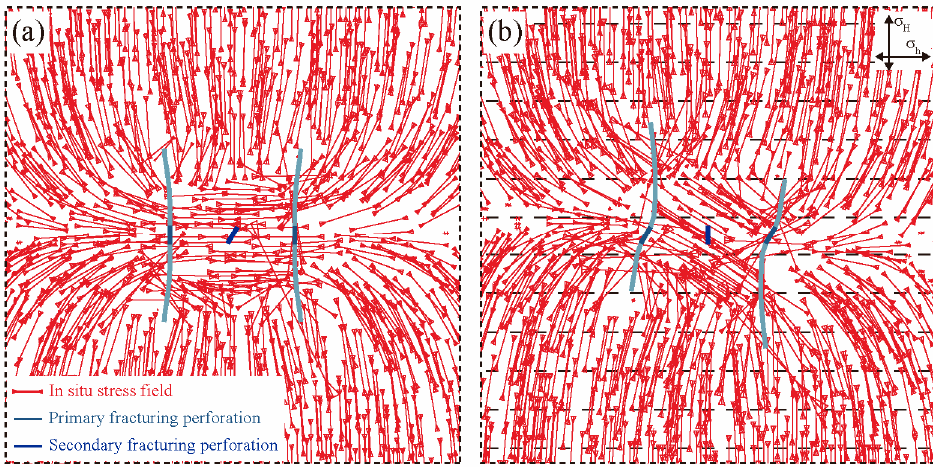
Figure 11. Distribution of secondary stress field. ( a ) Parallel perforating in the direction of maximum principal stress. ( b ) Perforated at 30 degrees with maximum principal stress.